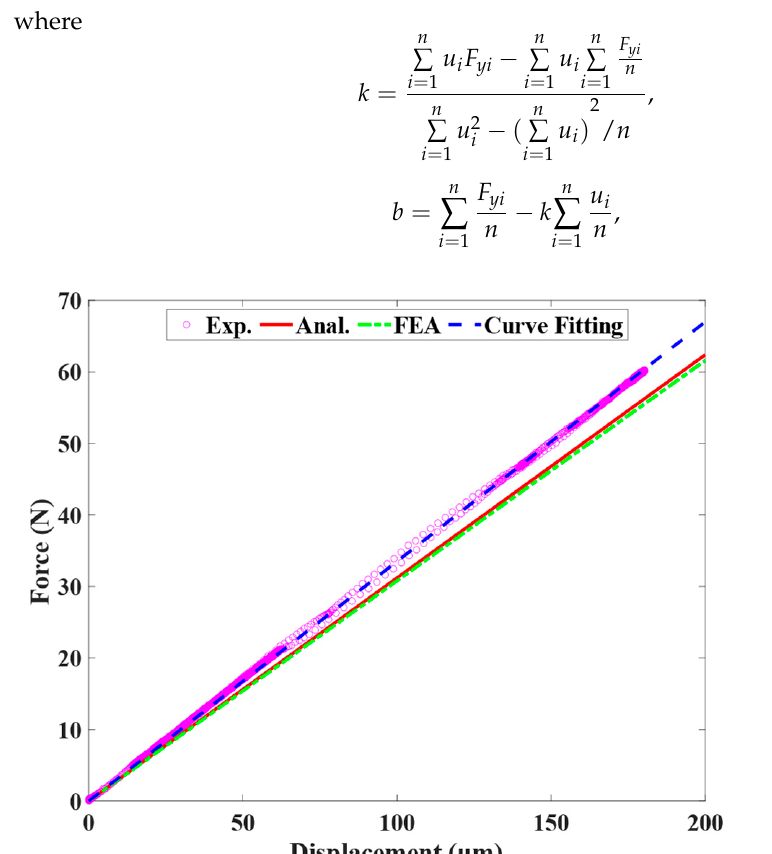
Figure 7. Comparative analysis of the stiffness k of the CEE. After the above treatment, the equivalent stiffness k of the CEE is calculated to be 0.335 N/ µ m. The equivalent stiffness k obtained from the analytical model and FEA results are 0.312 N/ µ m and 0.307 N/ µ m, respectively. The analytical and FEA results are also shown in Figure 7 as a comparison. Both the analytical model and FEA results slightly underestimate the equivalent stiffness, and the errors are calculated to be 6.87% and 8.36%,